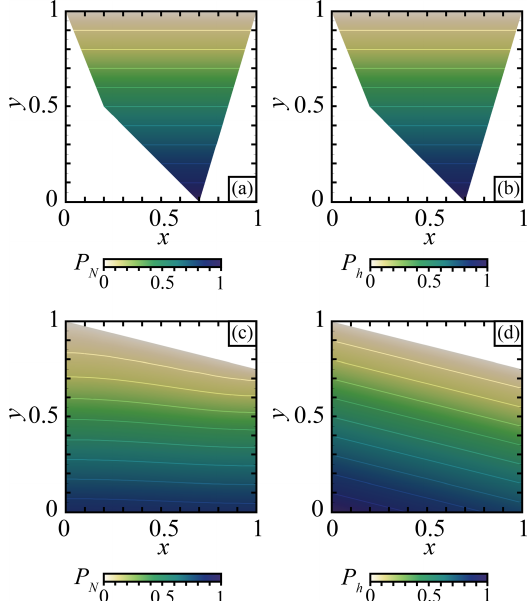
Figure 14. Pressure in non-dimensional models with constant den- sity ρ = 1. Pressure computed for a hydrostatic case in an irregu- larly shaped domain using (a) the normal equations (Eq. 45) and (b) the hyperbolic equation (Eq. 42). Pressure computed for a non- hydrostatic case due to topography using (c) the normal equation (Eq. 45) and (d) the hyperbolic equation (Eq. 42). The contour lines show contours of iso-pressure values every